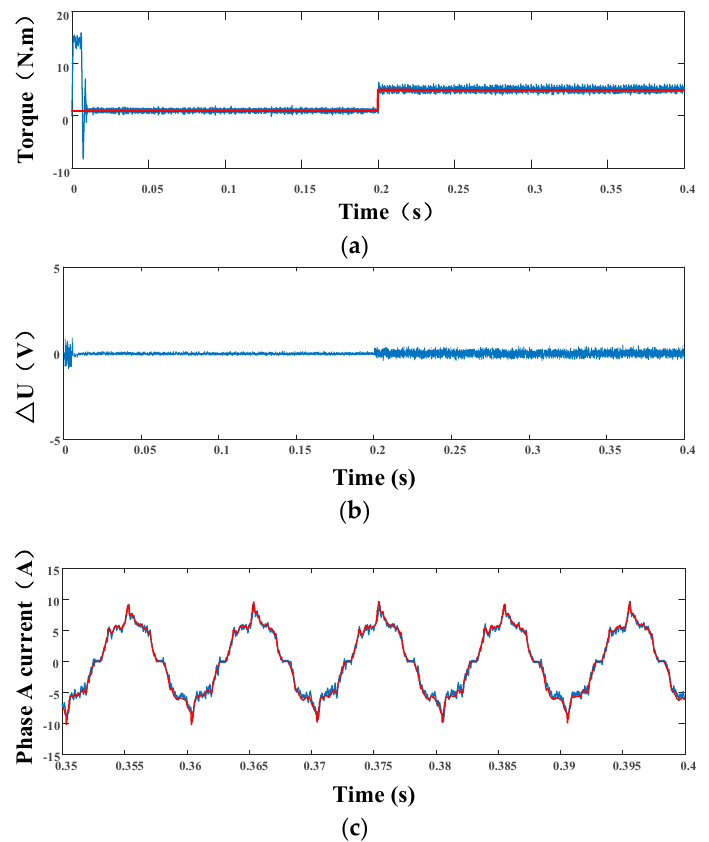
Figure 9. Simulated performance of current hysteresis control: ( a ) torque; ( b ) midpoint voltage deviation; ( c ) phase A current.